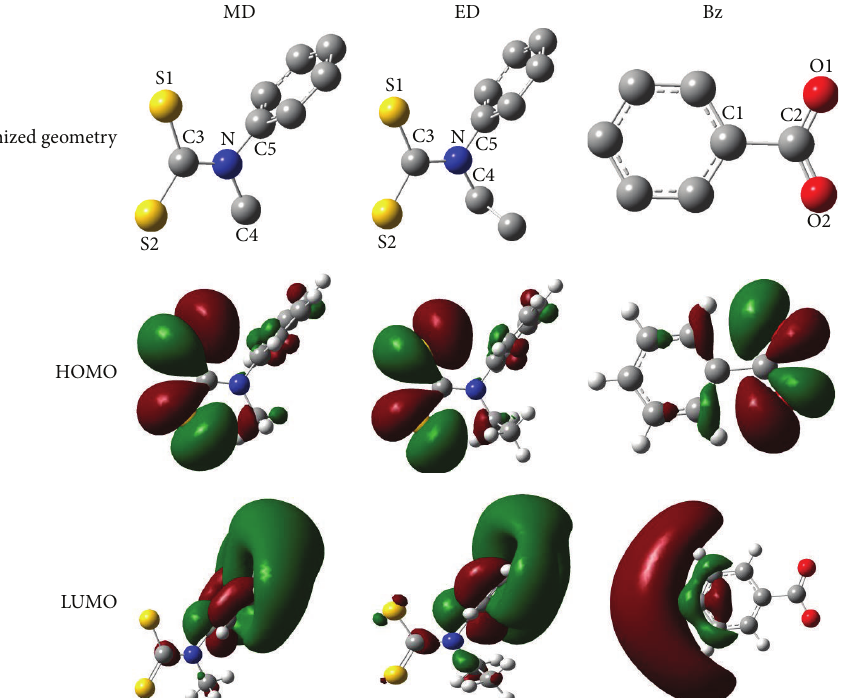
Figure 1: Optimized structures and HOMO and LUMO graphics of MD, ED, and Bz at B3LYP/6-31+G(d,p).